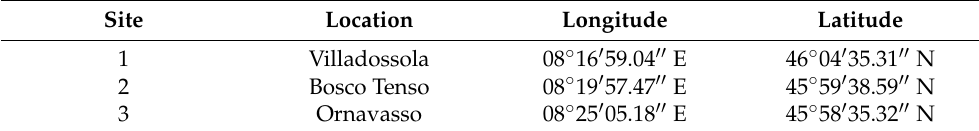
Table 1. Site coordinates.